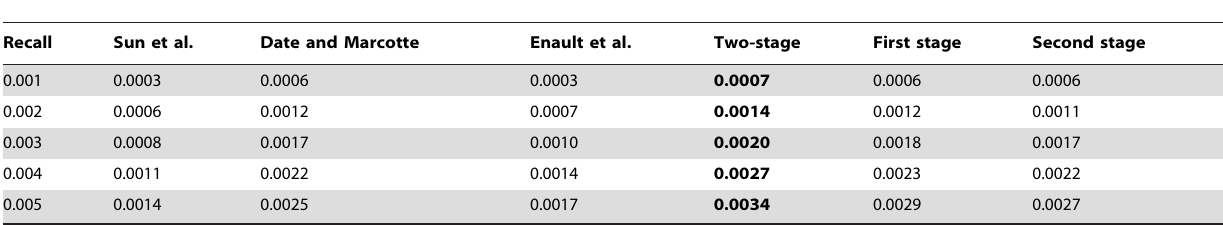
Table 2. Area under curve (AUC) comparison at specific recalls.